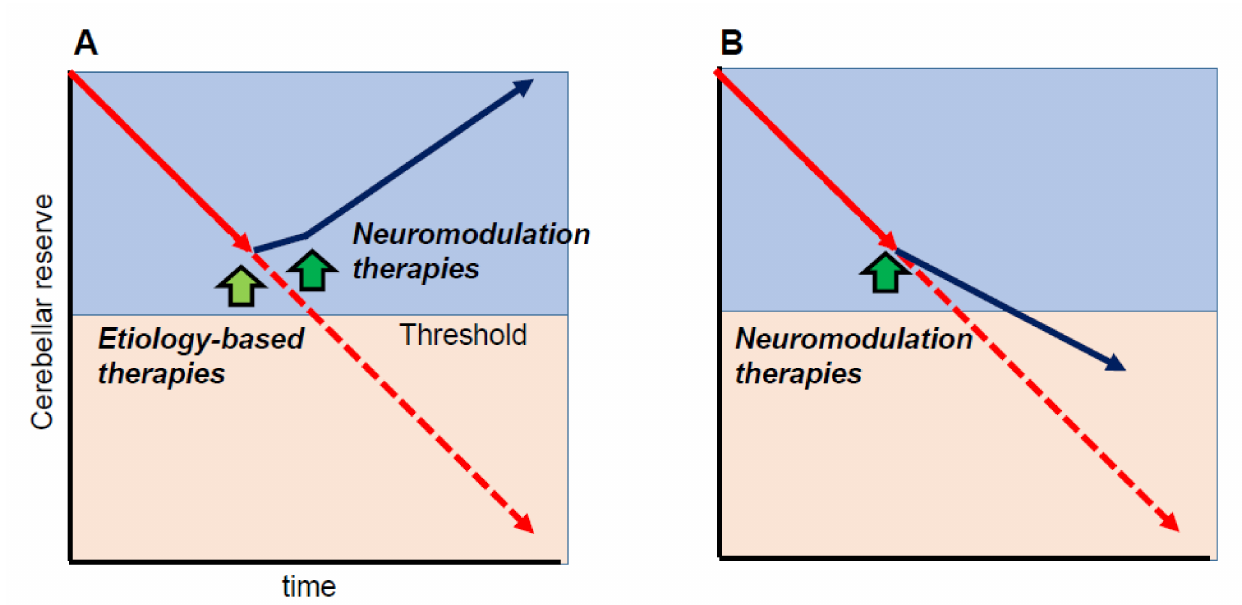
Figure 4. Schematic illustration of the effects of neuromodulation therapies. Neuromodulation therapies can modify cerebellar symptoms if the cerebellar reserve is preserved. ( A ) When etiology-based therapies are available (e.g., abstinence, removal of toxic agents, or diminishment of autoimmune processes,) and disease progression is stopped, neuromodulation therapies should improve cerebellar ataxias (CAs), leading to partial or full recovery of CAs. ( B ) When disease progression cannot be controlled (e.g., degenerative CA), early intervention by neuromodulation therapies can delay disease progres- sion. Yellow-green arrow indicates the timing of etiology-based therapies, whereas green arrows indicate the timing of neuromodulation